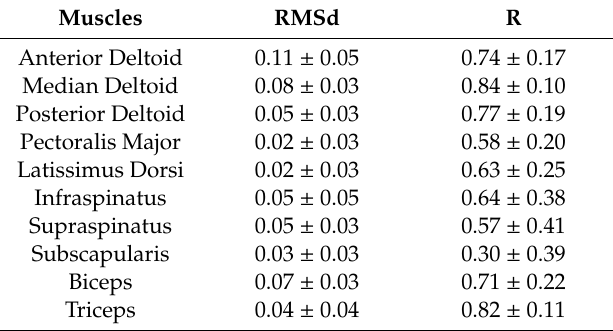
Table A1. RMSd and R between the experimental EMG of two di ff erent trials with a 6 kg load (mean ± 1 std for n = 36